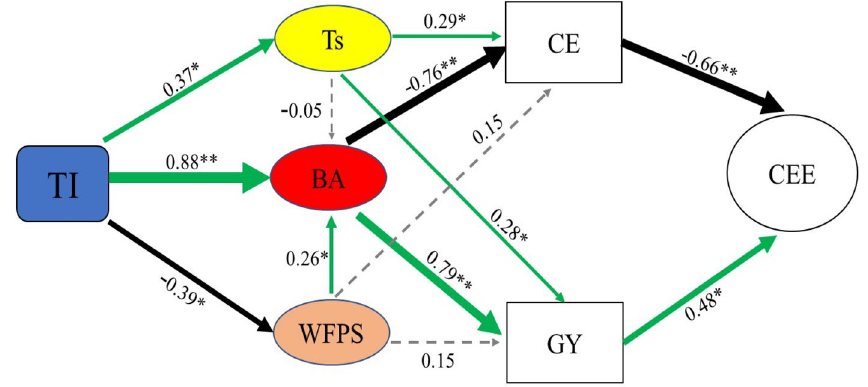
Figure 4. A structural equation of intercropping treatments effect on CEE, CE and GY in 2014–2016. The structural equation considered all possible pathways through soil temperature (Ts), soil water-filled pore space (WFPS) and crop biomass accumulation (BA) influence CEE, CE and GY in intercropping system. TI represents four intercropping treatments (NTSSI, NTSMI, TSRI, CTI). Green and black arrows represent significant positive and negative pathways, respectively. Grey dashed arrows indicate nonsignificant pathways. Arrow width is proportional to numbers indicate the standard path coefficients